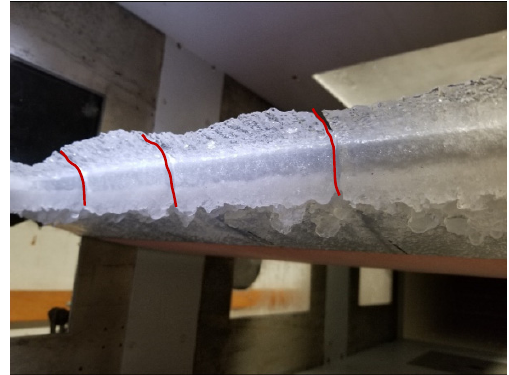
Figure 11. Ice shape at three different span locations.